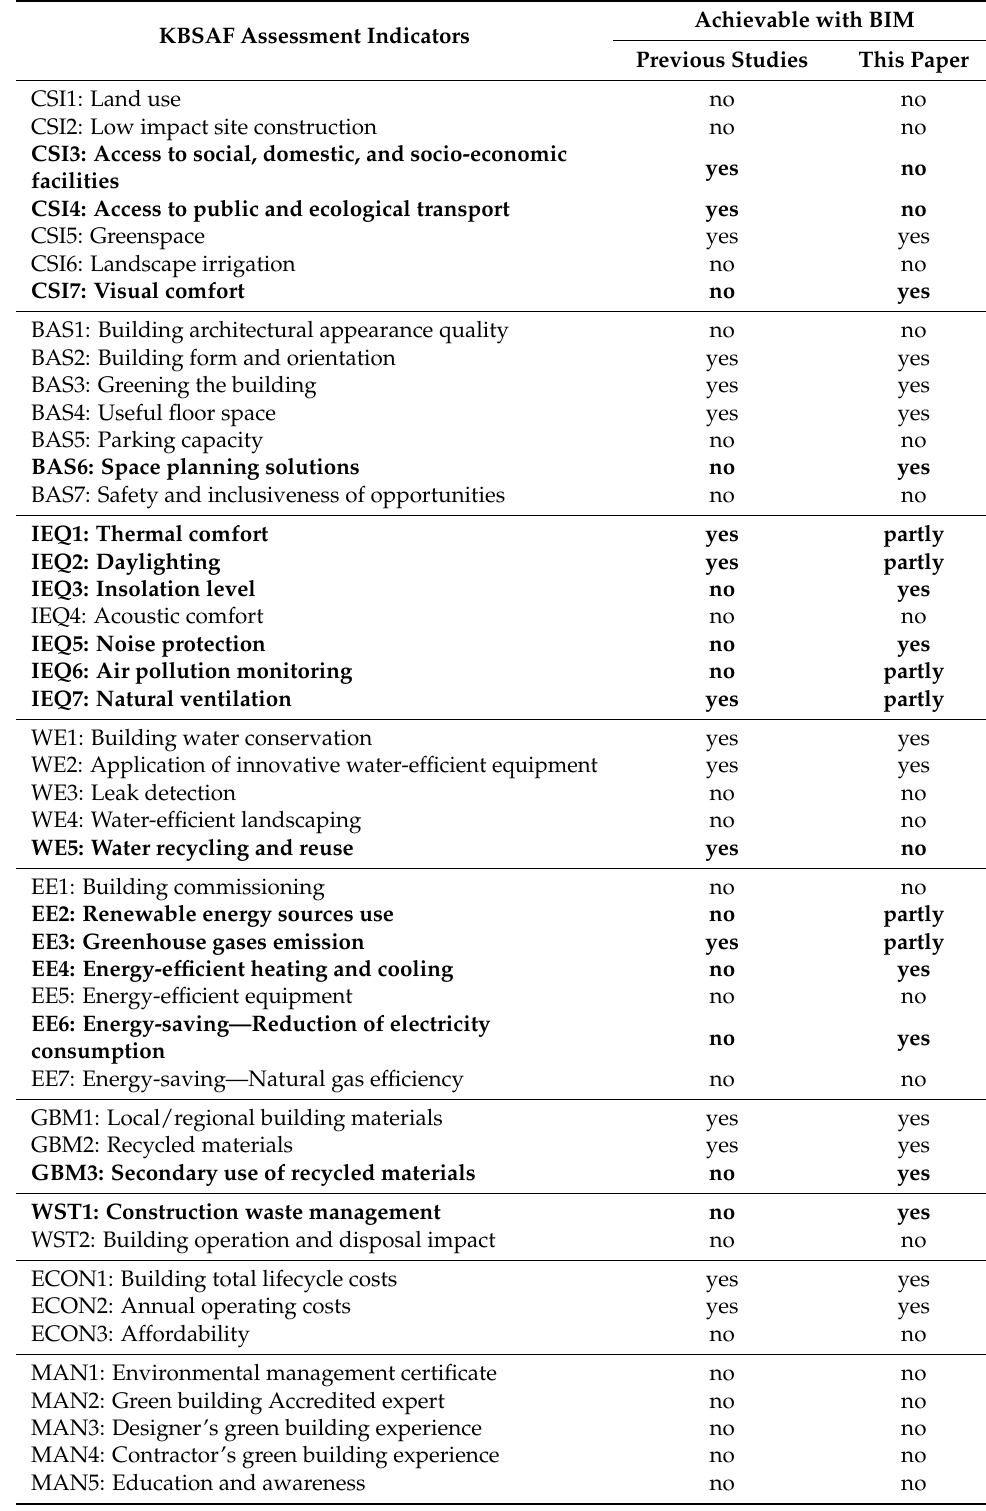
Table 4. Comparison of results of Tables 2 and